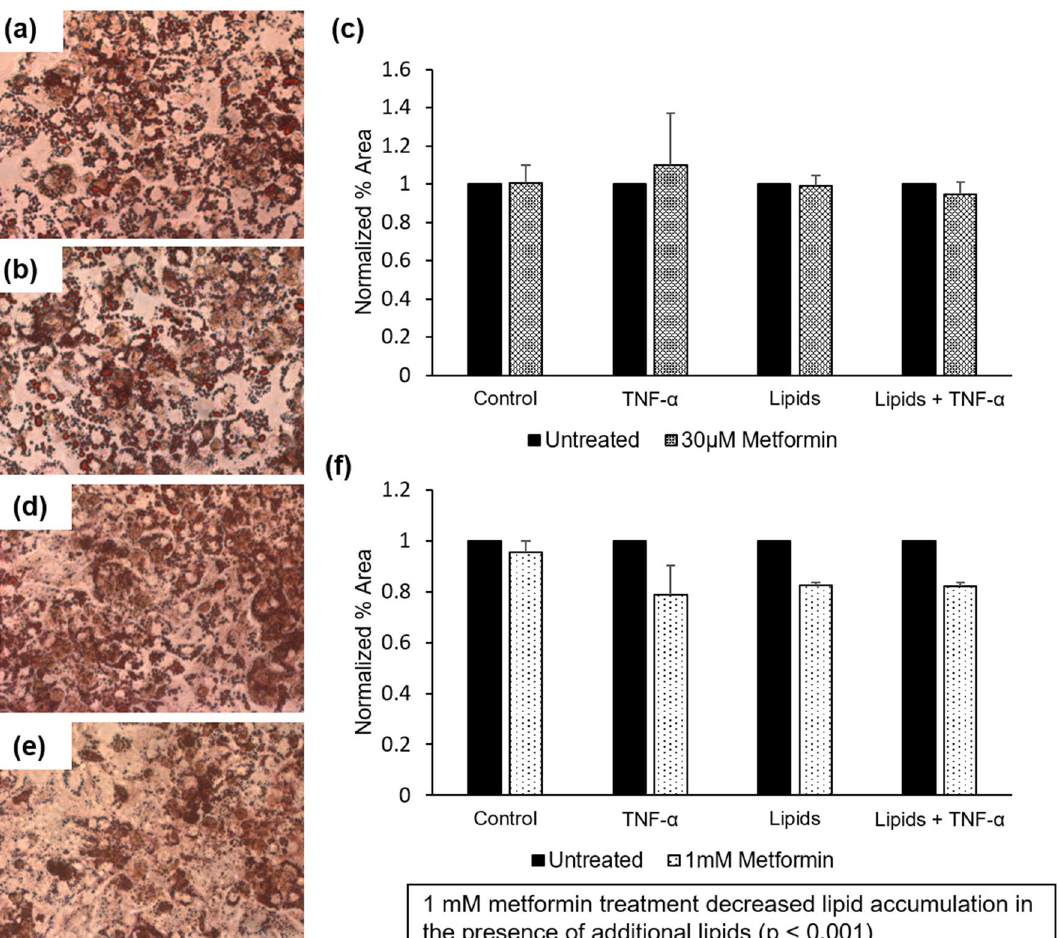
Figure 6. Oil Red O staining showing lipid accumulation in hepatocytes after 14 days in recirculating diabetic, obese, proinflammatory BMM with ( a ) Control ( b ) 30 μM Metformin. ( c ) Quantification of effect of metformin for each medium condition. Oil Red O staining showing lipid accumulation in hepatocytes after 7 days in recirculating diabetic, obese, proinflammatory BMM with ( d ) Control ( e ) 1 mM Metformin. ( f ) Quantification of the effect of metformin for each medium condition. Statistical analysis was performed with a one-way ANOVA followed by Dunnet’s test with the relative change in each condition to block for TNF-α addition and lipid addition (α = 0.05) using between 2 and 4 independent coverslips ( e ) or 3 independent coverslips per condition ( f